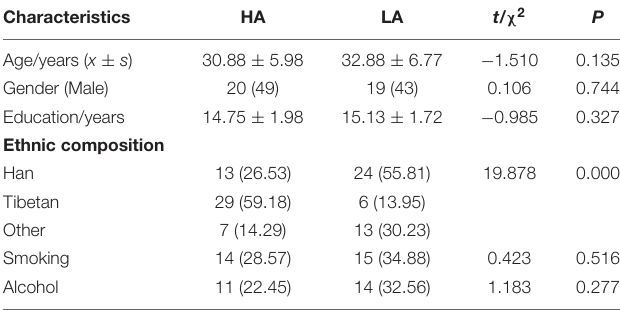
TABLE 1 | General characteristics of the two groups.